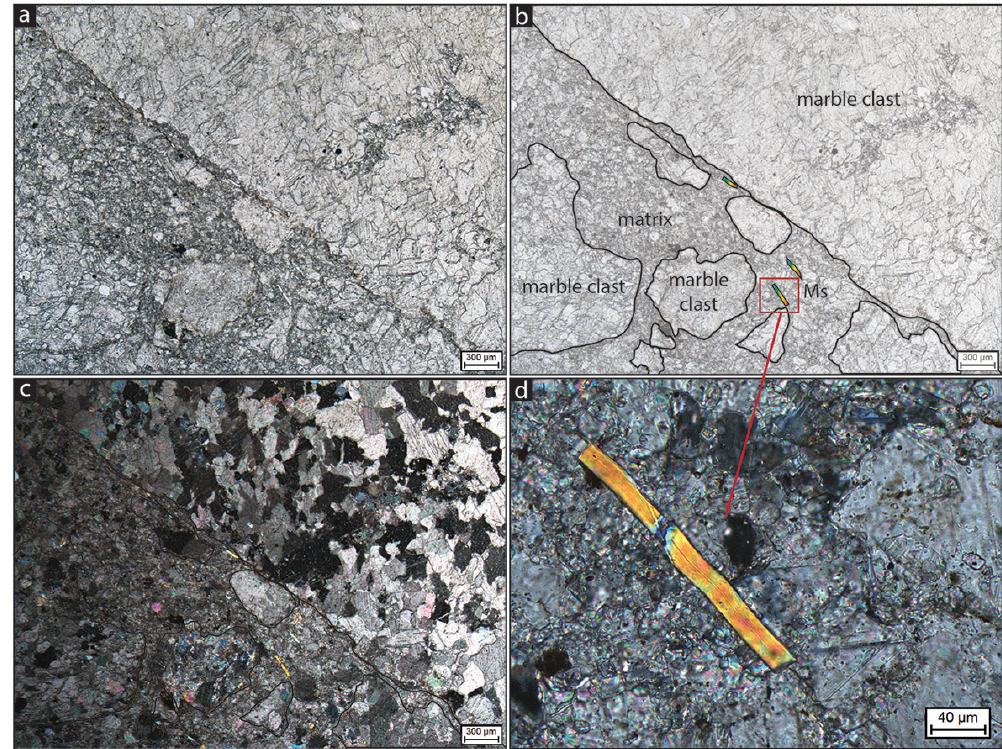
Figure 9. Microscopic view of breccia sample LHZ152. In plane-polarized light (a) ; redrawn (b) ; in cross-polarized light ( c and d